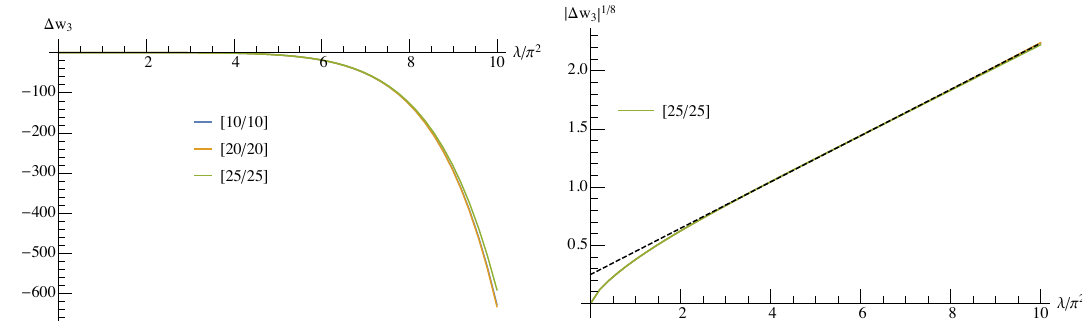
Figure 10 . (Left) Pad(cid:19)e-Borel resummation of (cid:1) w 3 with diagonal [ M=M ] approximants. (Right) 1 = 8 . The value 1 = 8 is be taken as a simple rational Qualitative (asymptotic) linear (cid:12)t of (cid:1) w 3 j j approximation to the unknown exact exponent (up to possible logarithmic